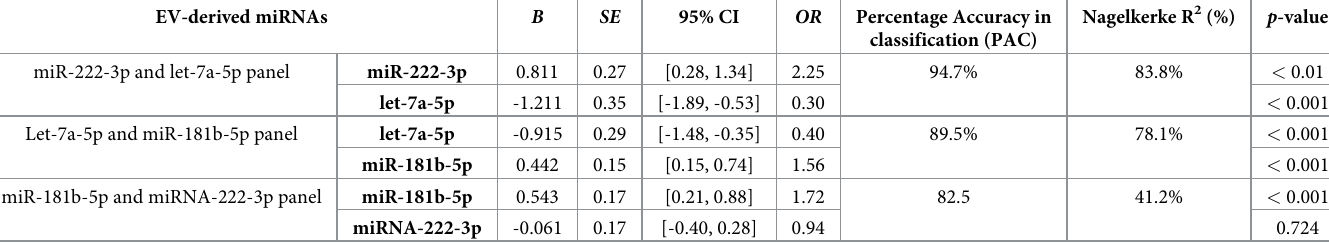
Table 4. Logistic regression miRNAs combination models for IBC diagnosis. EV-derived miRNAs B SE 95% CI OR Percentage Accuracy in